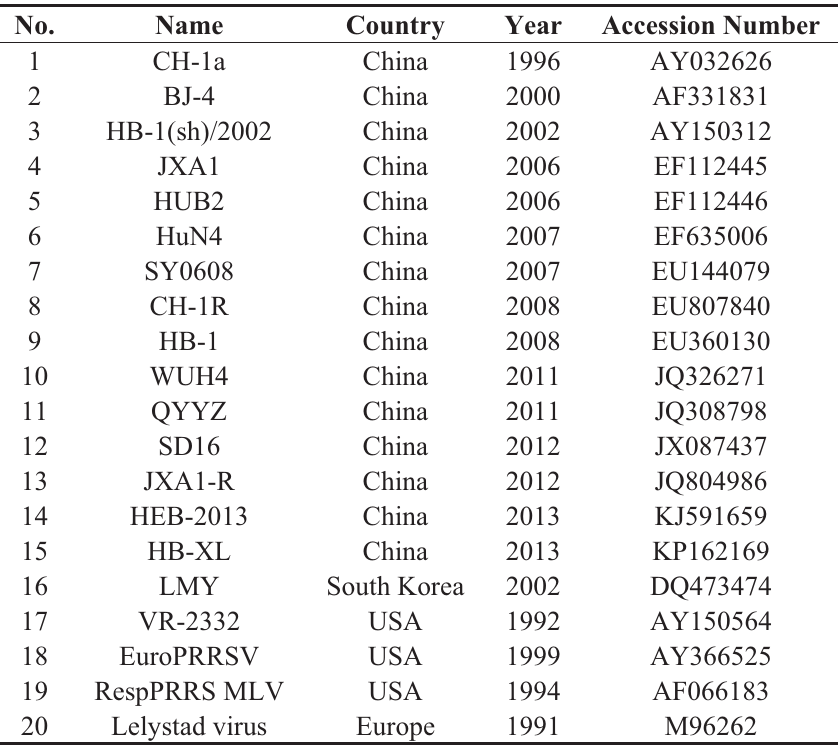
Table 2. Representative PRRSV strains used in this